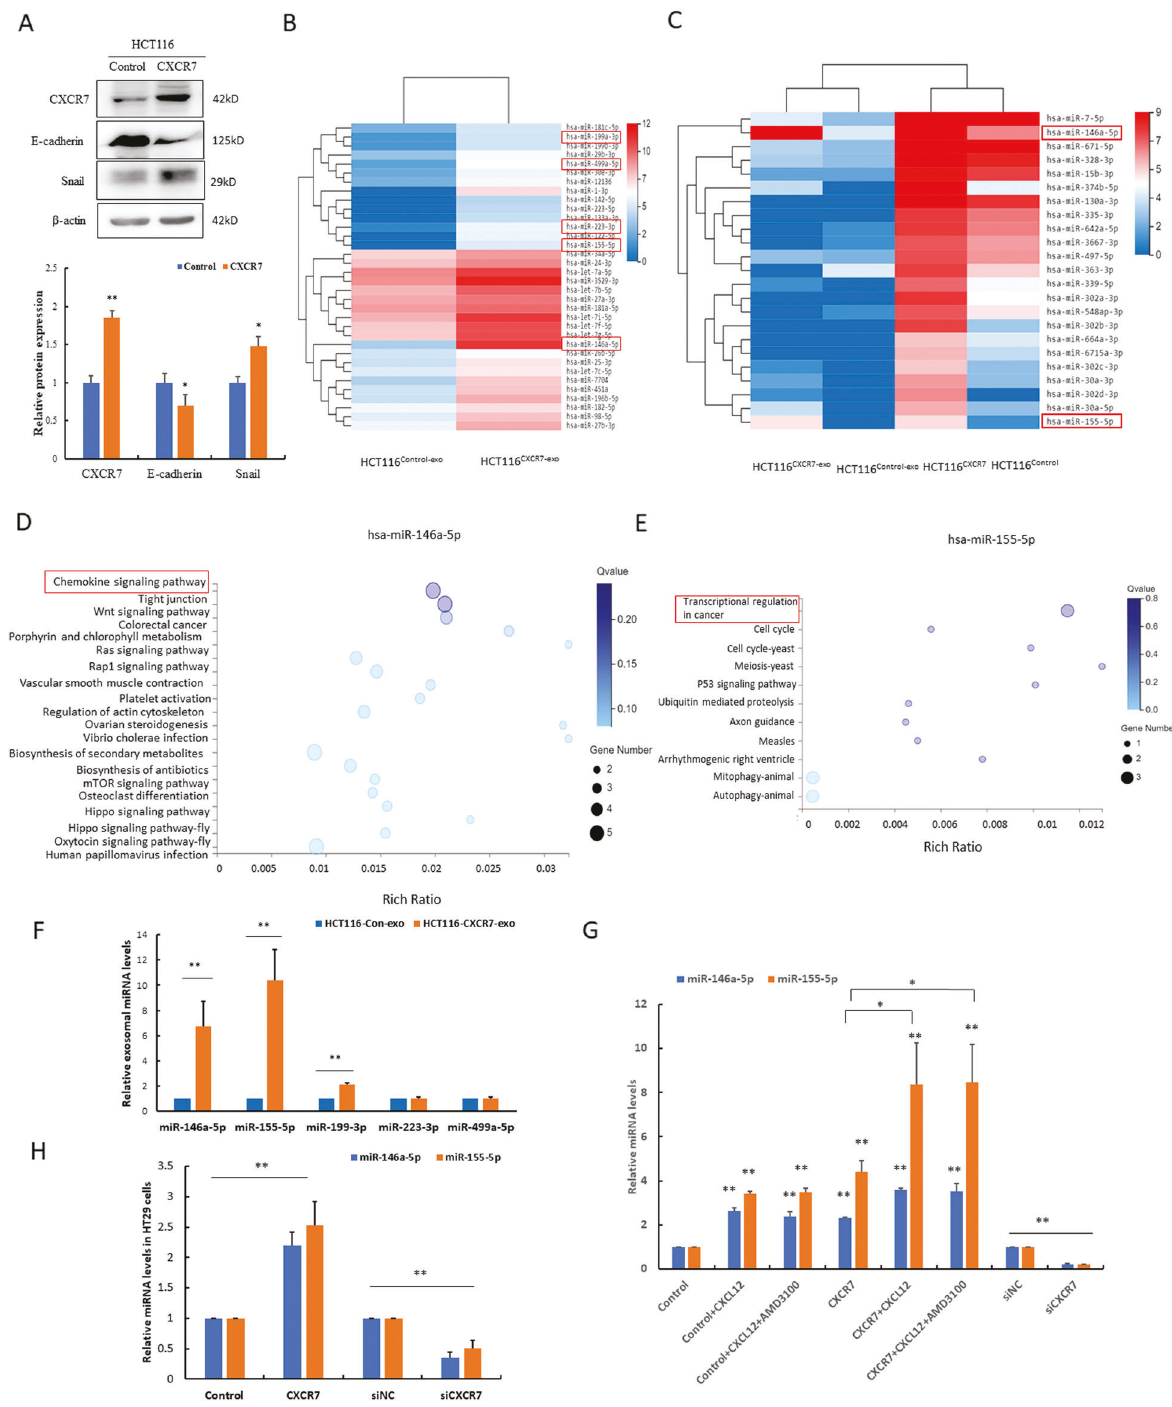
Fig. 3 Activation of the CXCL12/CXCR7 axis upregulated miR-146a-5p and miR-155-5p in both the CRC cells and their exosomes. A Western blot analysis of the expression of CXCR7, E-cadherin, Snail in HCT116 cells infected with lenti-CXCR7 and control and statistical analysis was performed. * p < 0.05 vs. control, ** p < 0.01 vs. control. B , C RNA sequencing was performed in both the exosomes and HCT116 cells infected with lenti-CXCR7 and control. Hierarchical clustering analysis of differentially expressing miRNAs was shown. The red box indicates the most upregulated miRNAs. D , E Enrichment bubble pattern shows the enrichment of predicted target genes of miR-146a-5p and miR-155-5p. X -axis represents rich ratio and Y -axis represents GO term. The size of bubble represents the gene number. Q value signi fi es statistical signi fi cance. F RT-qPCR analysis of the levels of miR-146a-5p, miR-155-5p, miR-199-3p, miR-223-3p, and miR-499a-5p in exosomes derived from HCT116 Control and HCT116 CXCR7 cells. ** p < 0.01 vs. control. G , H RT-qPCR analysis of the levels of miR-146a-5p and miR-155-5p in HCT116 and HT29 cells infected with siRNA or lenti-CXCR7 stimulated by CXCL12 (100 ng/ml) with or without AMD3100 as indicated. * p < 0.05, ** p < 0.01.